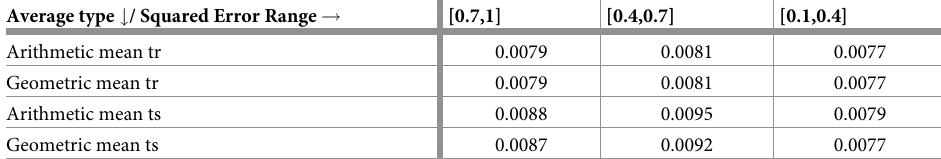
Table 3. Arithmetic and geometric mean obtained from the sum of squared error in 20 implementations of ANN-BTA network in three ranges of [0.1, 0.4], [0.4, 0.7], [0.7, 1].